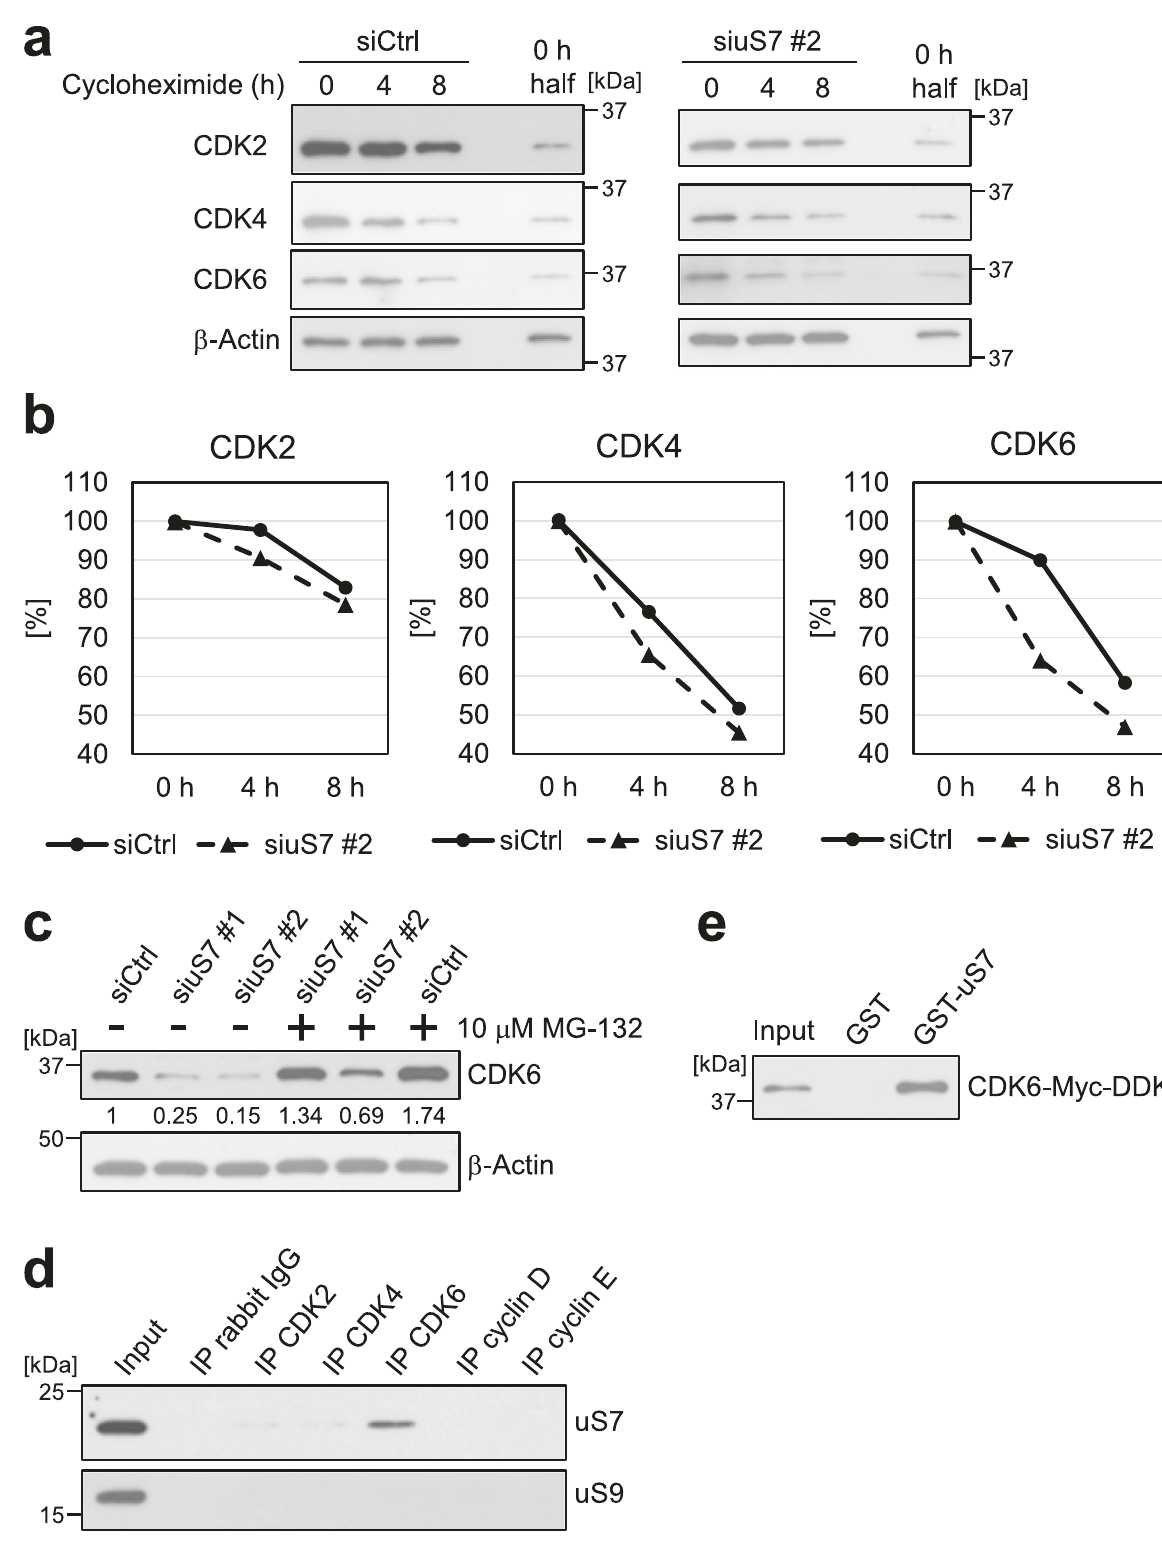
Methods Cell culture . Human colon cancer HT-29 cells were obtained from the NCI-60 cancer cell line panel of the National Cancer Institute Developmental Ther- apeutics Program. Human colon cancer SW480 cells were obtained from the American Type Culture Collection. These cells were maintained in Dulbecco ’ s modi fi ed Eagle ’ s medium (DMEM) supplemented with 10% fetal bovine serum COMMUNICATIONS BIOLOGY| (2022) 5:564